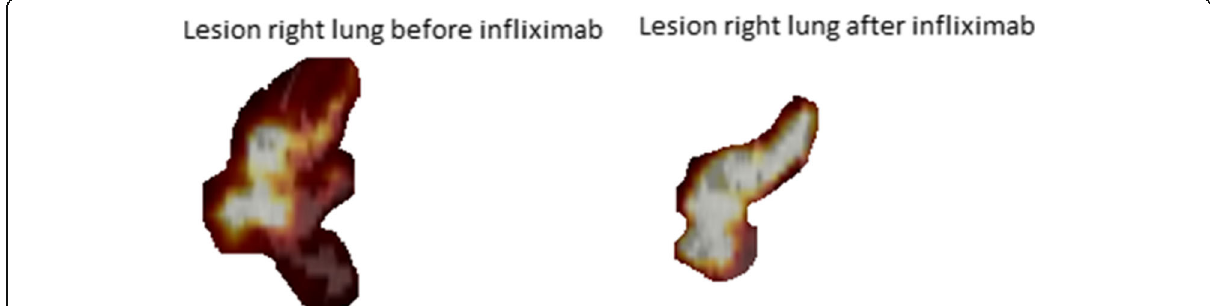
Fig. 3 Patient A. Pre- and post- 18 F-FDG PET/CT, lesion in the right lung with a significant decrease in TLuG and a significant increase in DLCOc (% predicted), while SUVmax increases. Patient A showed persistent extensive parenchymal and endobronchial involvement with an impaired diffusion capacity despite corticosteroid treatment. Infliximab was initiated, and after 6 months of treatment, diffusion capacity increased with 9.8%. Furthermore, TLuG decreased with 11.8%. However, in contrast to TLuG, the SUVmax increased with +